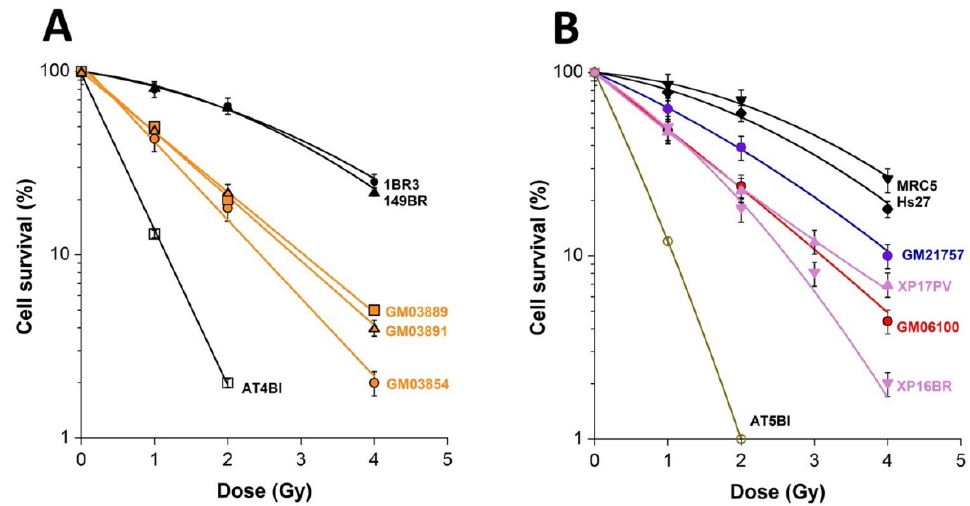
Figure 1. Clonogenic cell survival in USH1 fibroblasts: A clonogenic cell survival assay was applied to the radioresistant controls 1BR3 and 149BR, the hyper-radiosensitive ATM -mutated AT4BI, and the three USH1 (GM03854, GM03889, and GM03891) fibroblast cell lines ( A ), and to the radioresistant controls MRC5 and Hs27, the hyper-radiosensitive ATM -mutated AT5BI, the HD (GM21757), the TSC (GM06100), and two XPD (XP16BR and XP17PV) fibroblast cell lines ( B ). Each plot represents the mean ± SEM of three replicates. Survival data were fitted to the LQ model.